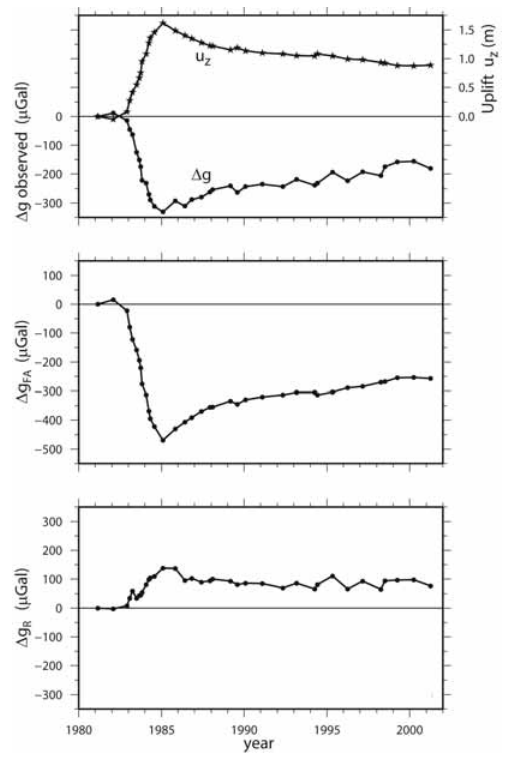
Fig. 2a-c. a) gravity variations and elevation change observed during 1981-2001 at Serapeo ro- man market (Pozzuoli), at the center of CF; b) grav- ity due to the ground uplift (free-air correction); c) residual gravity due to the difference between the ob- served and the free-air corrected